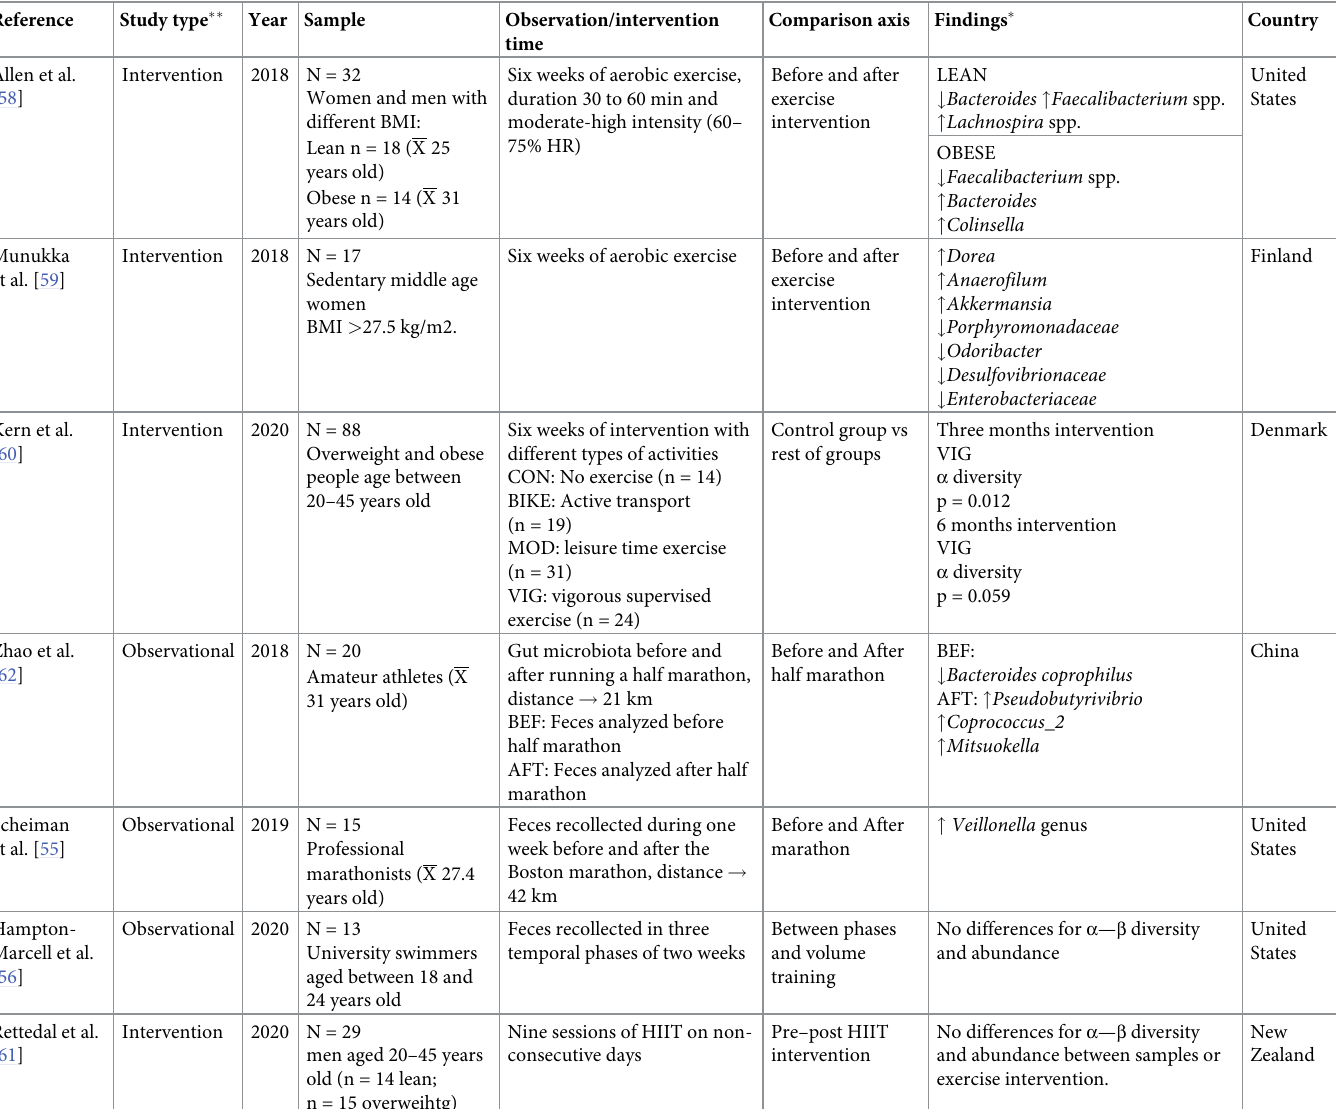
Table 2. Longitudinal studies containing two or more samples of feces, before and after exercise